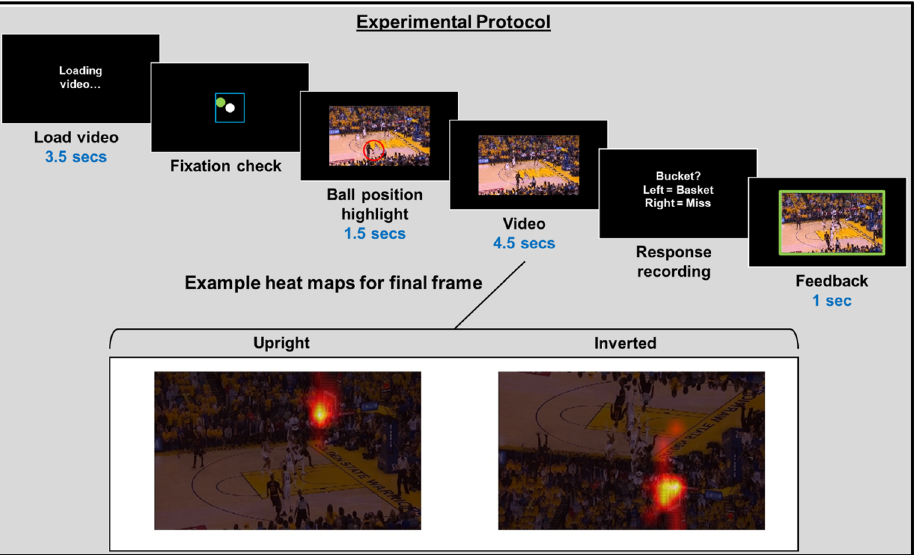
Figure 1. Graphic depicting experimental protocol, and example heat maps for final frame of a video. Heat map created using Matlab